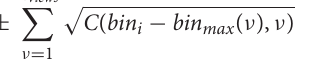
number of events for each time frame is reported in the Supplementary Table 1